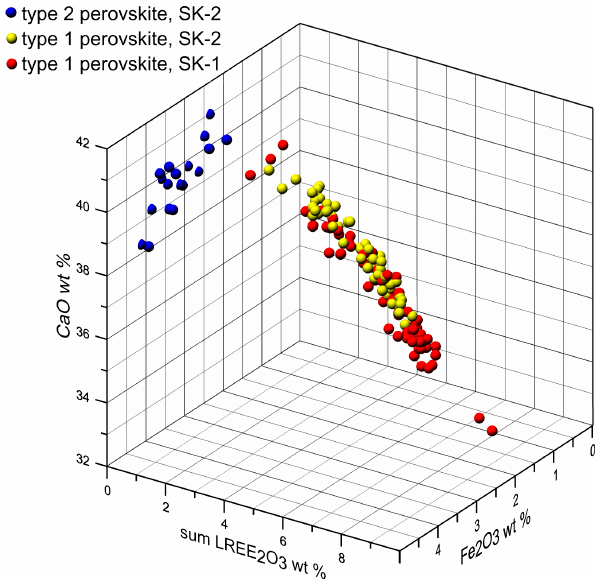
Figure 4. CaO- ∑ LREE 2 O 3 -Fe 2 O 3 (wt %) plot of type 1 perovskite from SK-1 and SK-2 and type 2 perovskite from SK-2.